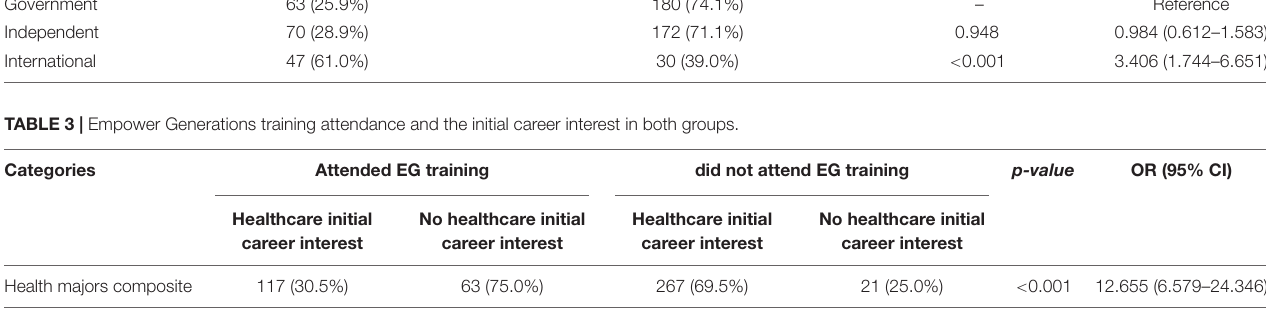
TABLE 4 | Empower Generations training and university’s cumulative GPA of health majors composite.